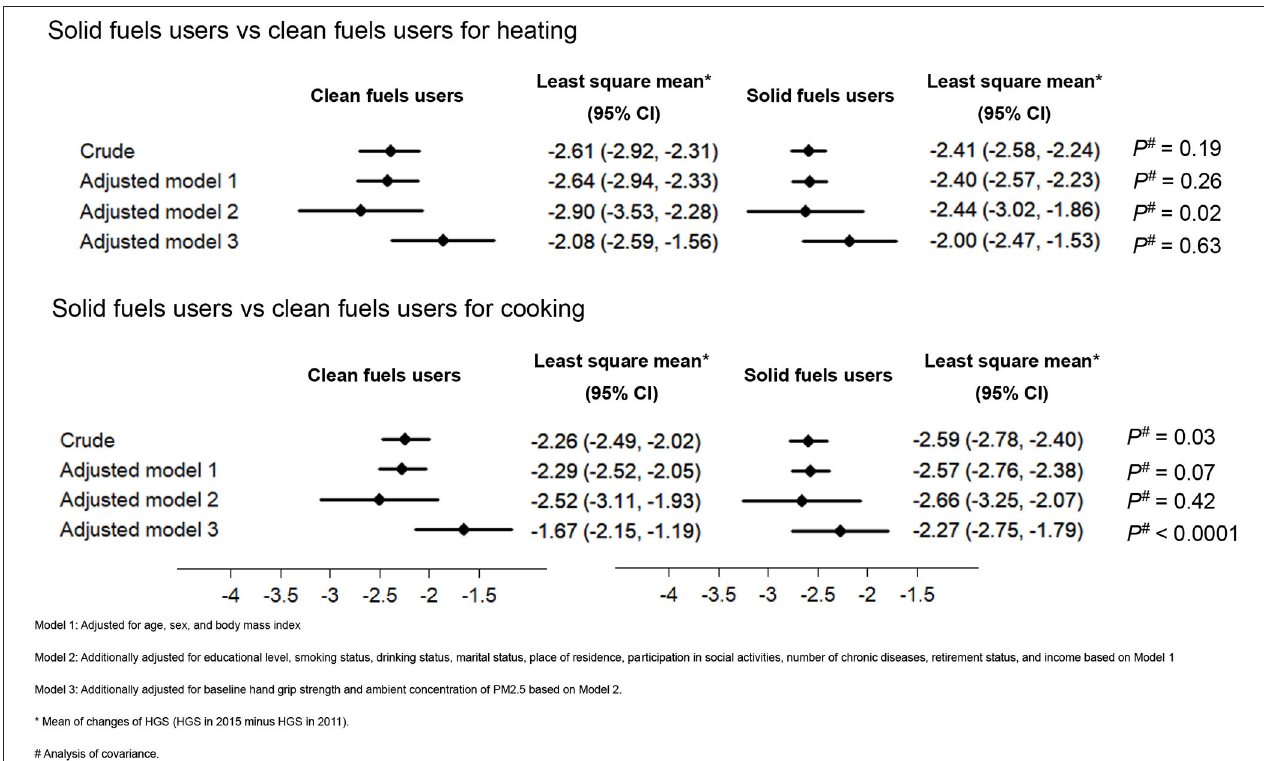
FIGURE 2 | Associations between different purposes of solid fuel use and changes of HGS. HGS, handgrip strength.